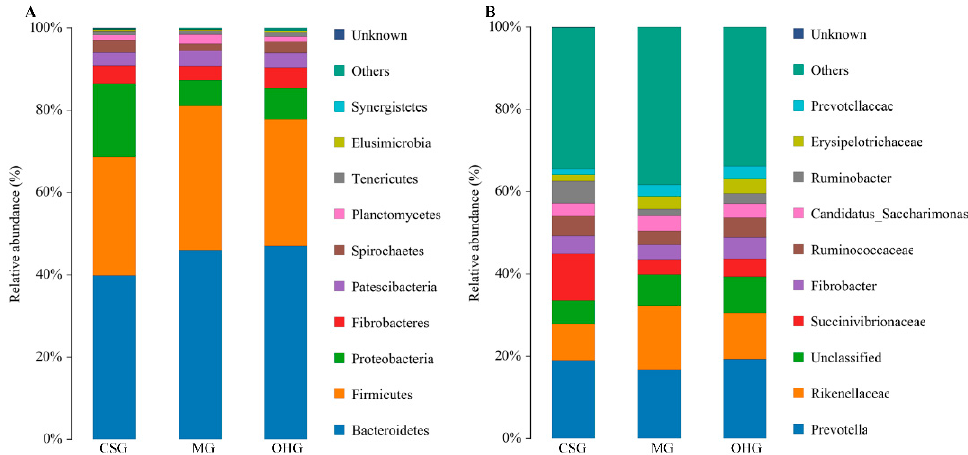
Figure 4. Community composition of bacteria in different groups. The tax level of phylum ( A ), the tax level of genus ( B ).